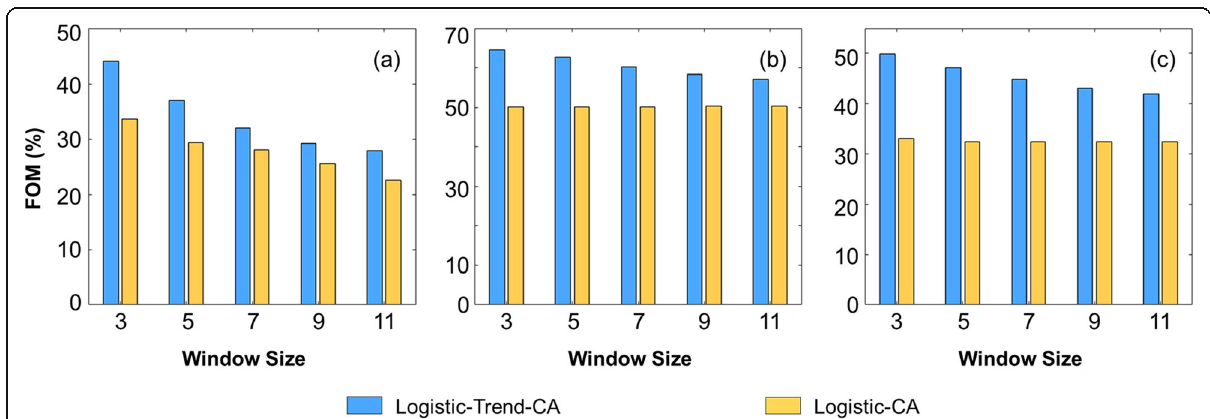
Fig. 10 Assessment of urban sprawl modeling using different neighborhood sizes. Urban sprawl modeling in the Beijing-Tianjin-Hebei region at the 1-km resolution from 1992 to 2013 ( a ) and in Beijing ( b ) and Tianjin ( c ) at the 30-m resolution from 1985 to